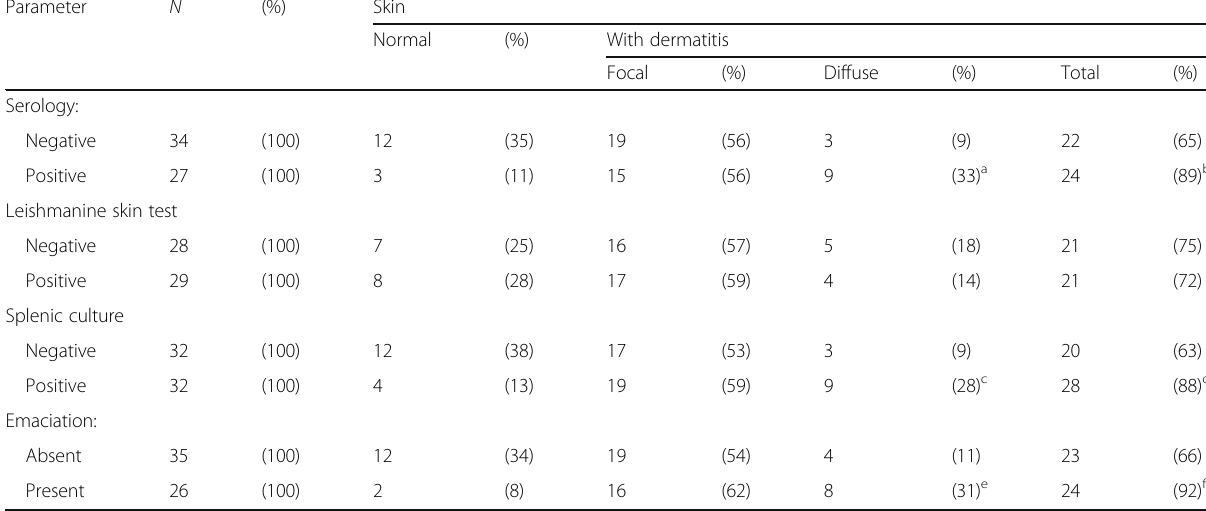
a-f Statistically different from the group with normal skin, Chi-square test: a P =0.01; b P =0.06, c P =0.02; d P =0.04; e P =0.01; and f P